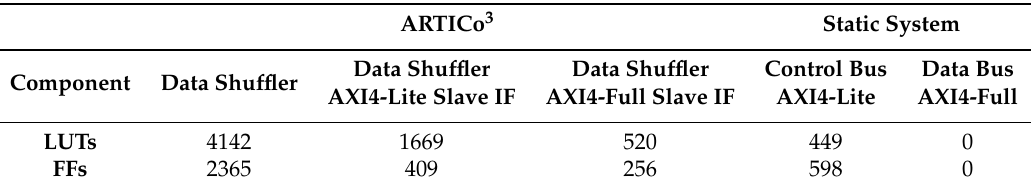
Table 3. Resource utilization: ARTICo 3 infrastructure